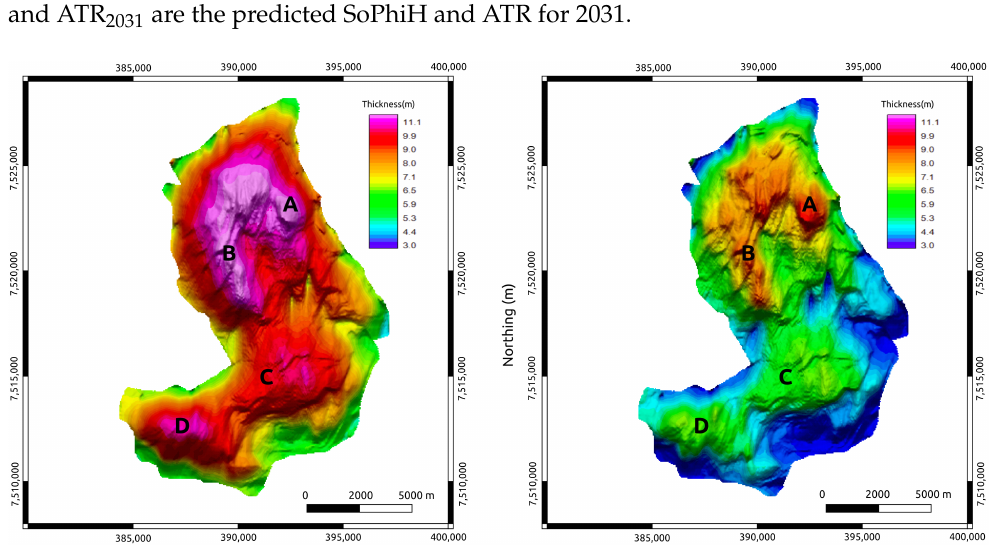
Figure 14. SoPhiH maps predicted based on the CSEM inversion of the MR3D reservoir. ( Left panel ) The base year (2021). ( Right panel ) The monitoring year (2031). A, B, C, and D are anomalous oil zones associated with the reservoir’s thickest portions; compare with the true SoPhiH maps of the flow simulation in Figure